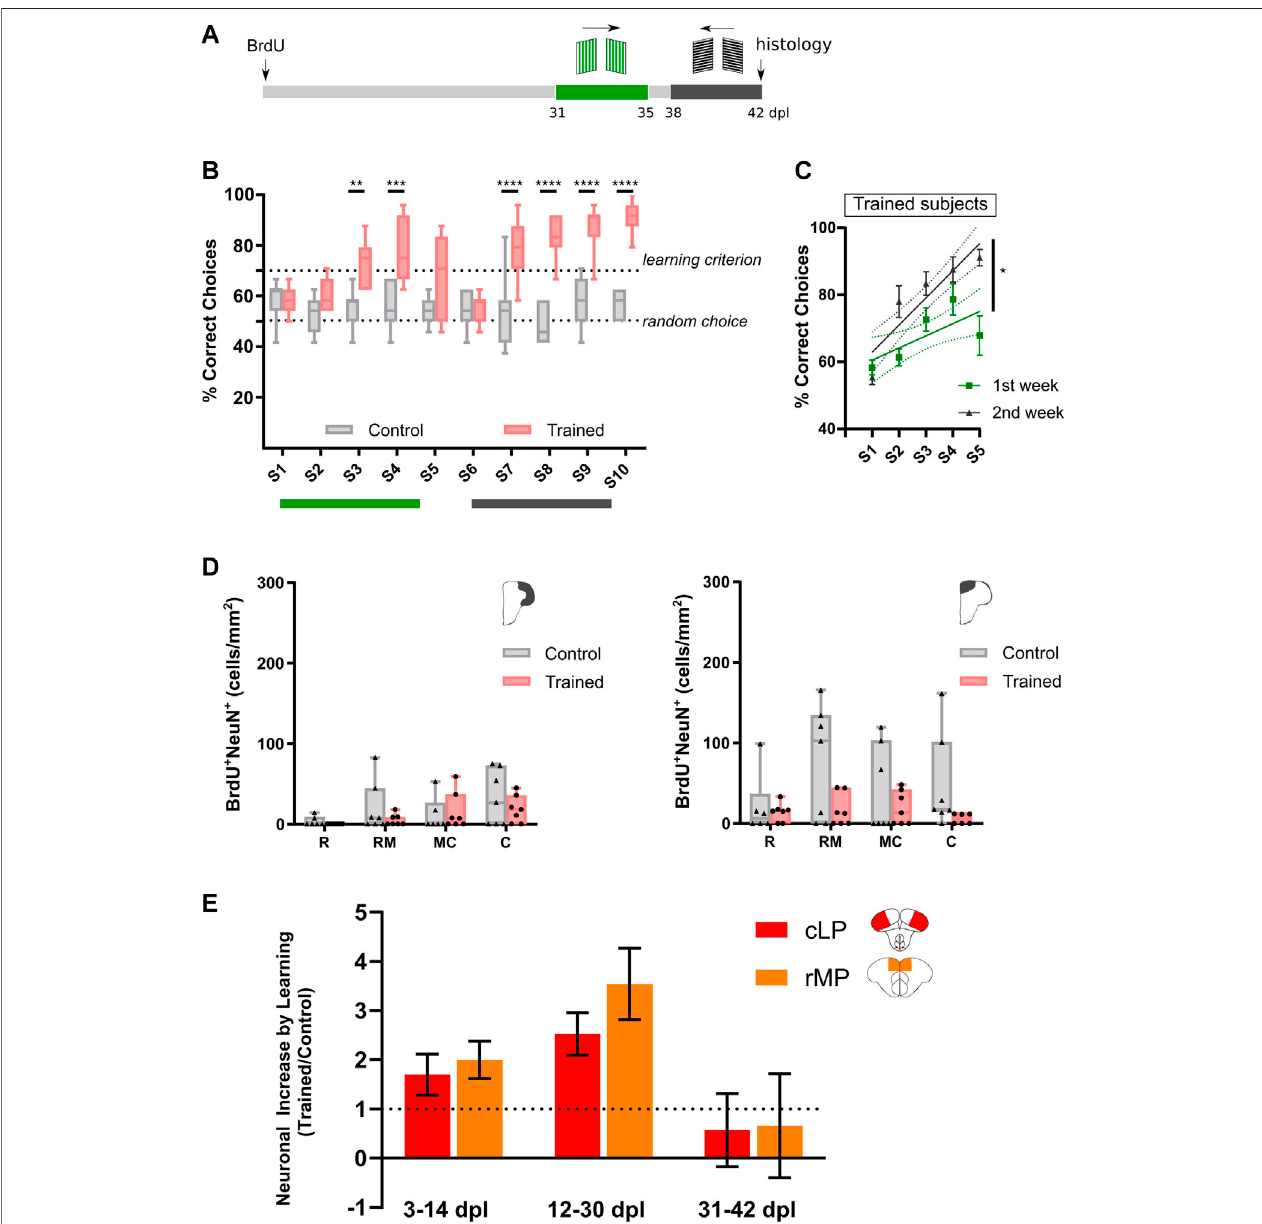
FIGURE4| Trainingadultzebra fi shduringalateperiod (31 – 42dpl)hasnoeffectonpallialneurogenesis. (A) .Experimentaldesign. (B) .LearningcurvesforTrained and Control individuals. (Two-way RM ANOVA, Treatment effect: F (1, 12) = 108.0 with p < 0.0001, Session effect: F (9, 108) = 6.800 with p < 0.0001. Bonferroni ’ s multiple comparisonstest,** p < 0.01,*** p < 0.001,**** p < 0.0001.Trained,N=7;ControlN=7). (C) .SimplelinearregressionforeachtrainingwindowforTrained fi sh(ANCOVA, F (1,66) =5.914,*indicates p < 0.05.Trained,N=7;ControlN=7). (D) .BrdU + NeuN + cellquanti fi cationinLP(left)andMP(right)(Kruskal – Wallistestwith:Leftpanel, p =0.1984;Rightpanel, p =0.316. Dunn ’ smultiplecomparisons test, notsigni fi cantdifferences werefound.Trained, N=7;Control, N=7). (E) . Neuronal increase ratio (Trained/Control) in rMP and cLP for each learning time